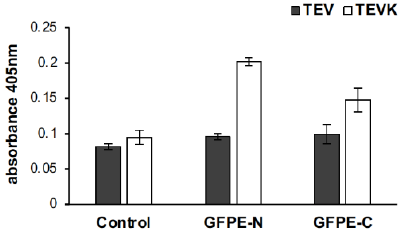
Figure 7. Interaction analysis of TEVK VLPs with GFPE-N and GFPE-C proteins by ELISA. GFPE- N or GFPE-C versions were used as capture antigens. Anti-TEV alkaline phosphatase-labeled anti- body was used to measure the interacting